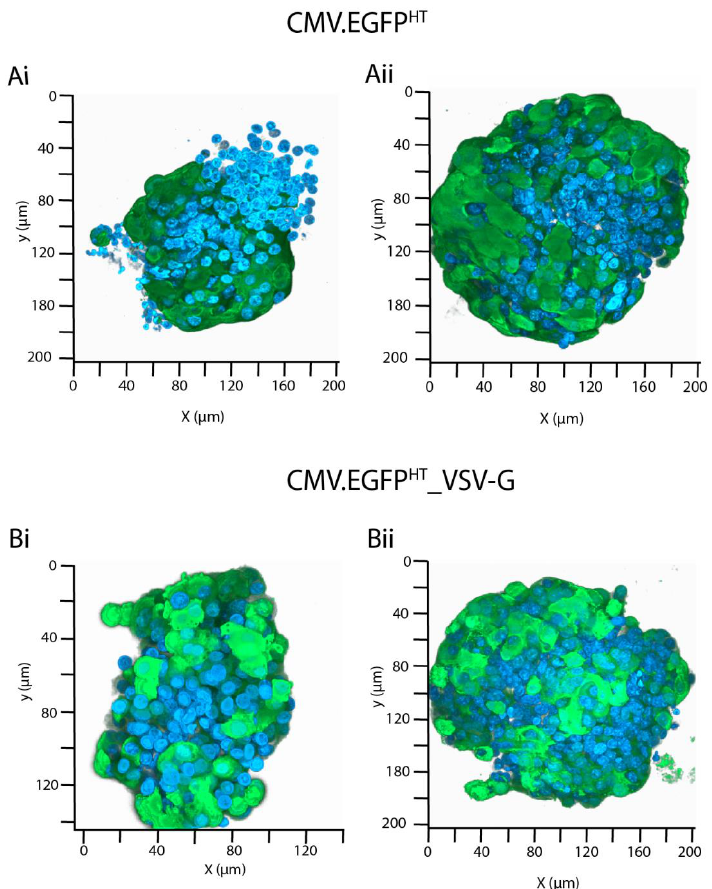
Figure 7. Human pancreatic islets isolated from cadaveric donor 2 were transduced with ( A ) CMV.EGFP HT or ( B ) CMV.EGFP HT _VSV-G BacMam viruses at 250 MOI (two representative images